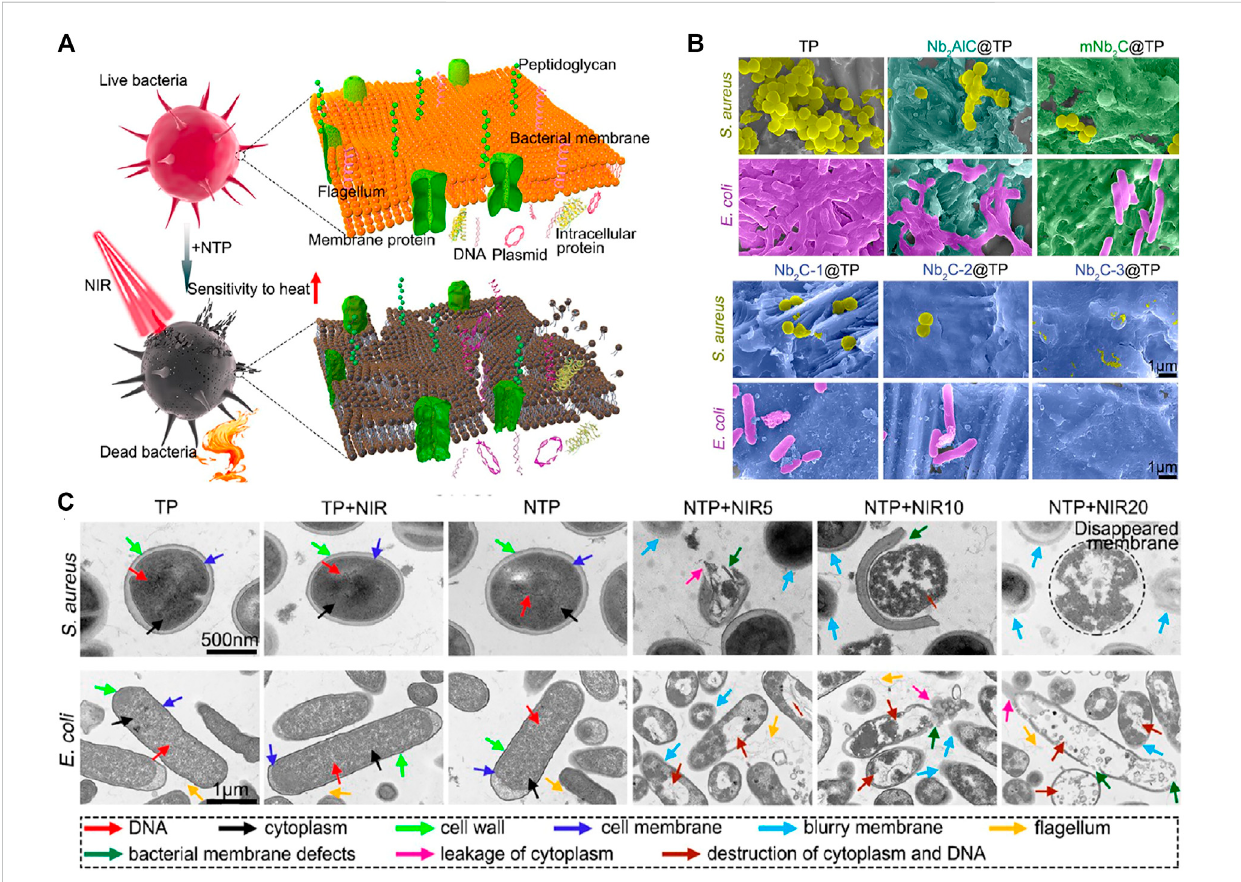
FIGURE 2 (A) SchematicillustrationofthetherapeuticstrategyforbacterialinfectionbasedonNb different groups. (C) TEM images of antibacterial performance in different groups. (Adapted with permission from Yang et al., 2021. Copyright 2021 American Chemical